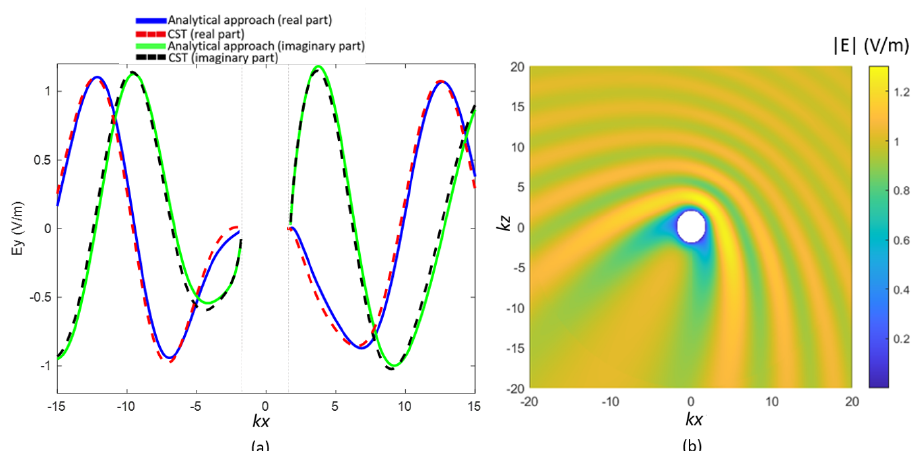
Figure 10. Real and imaginary parts of E y along the x -axis and comparison with the results obtained through CST Microwave Studio ( a ); magnitude of the E-field across the xz -plane ( b ). Used parameters were as follows: θ 0 = 30 ◦ , ka = 2, kb = 1.7321, c = 1, ξ 0 = 2, d = 2, m t = 6. TE polarization.